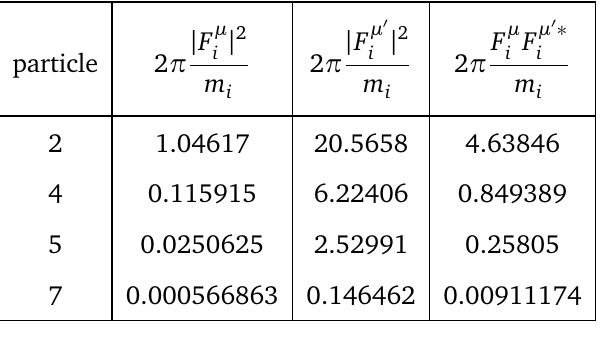
ij , i , j = µ , µ (cid:48) S